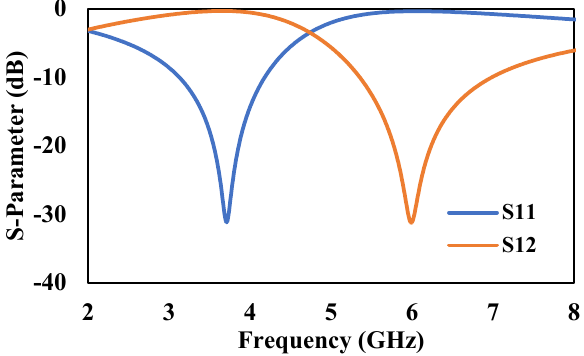
Figure 7. S-Parameter response of metallic-cross Unit-cell.